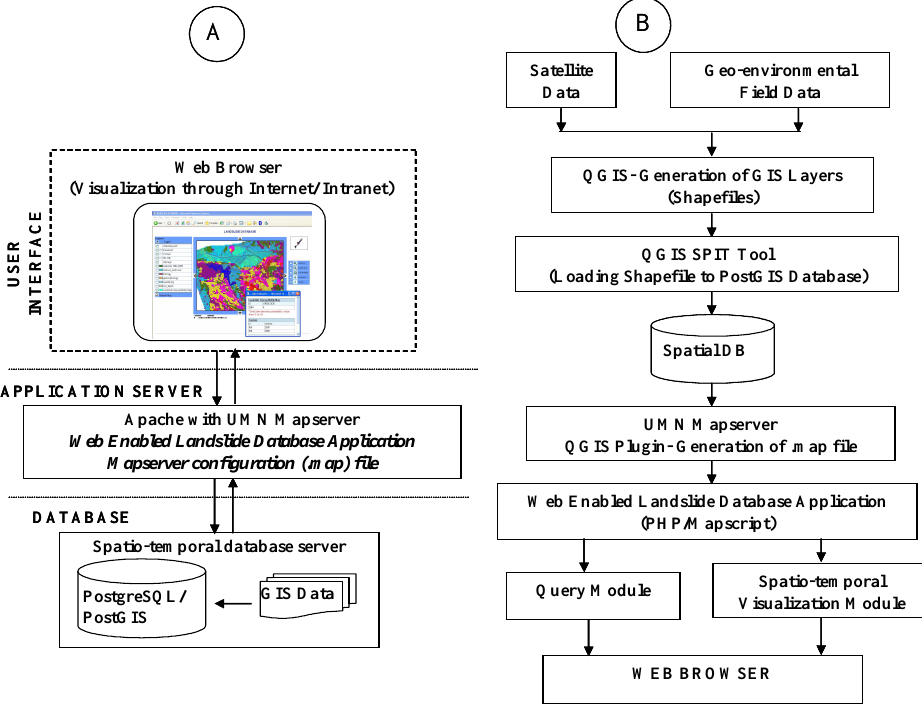
Figure 4. System architecture (A) and Methodology (B) followed in the present study for the development of web enabled landslide database web application